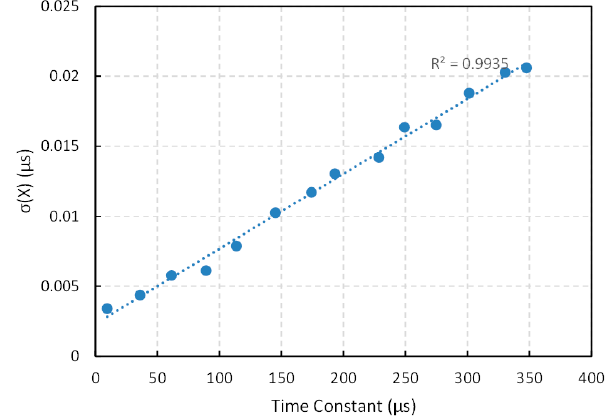
( ) x versus the time constant of the capture module